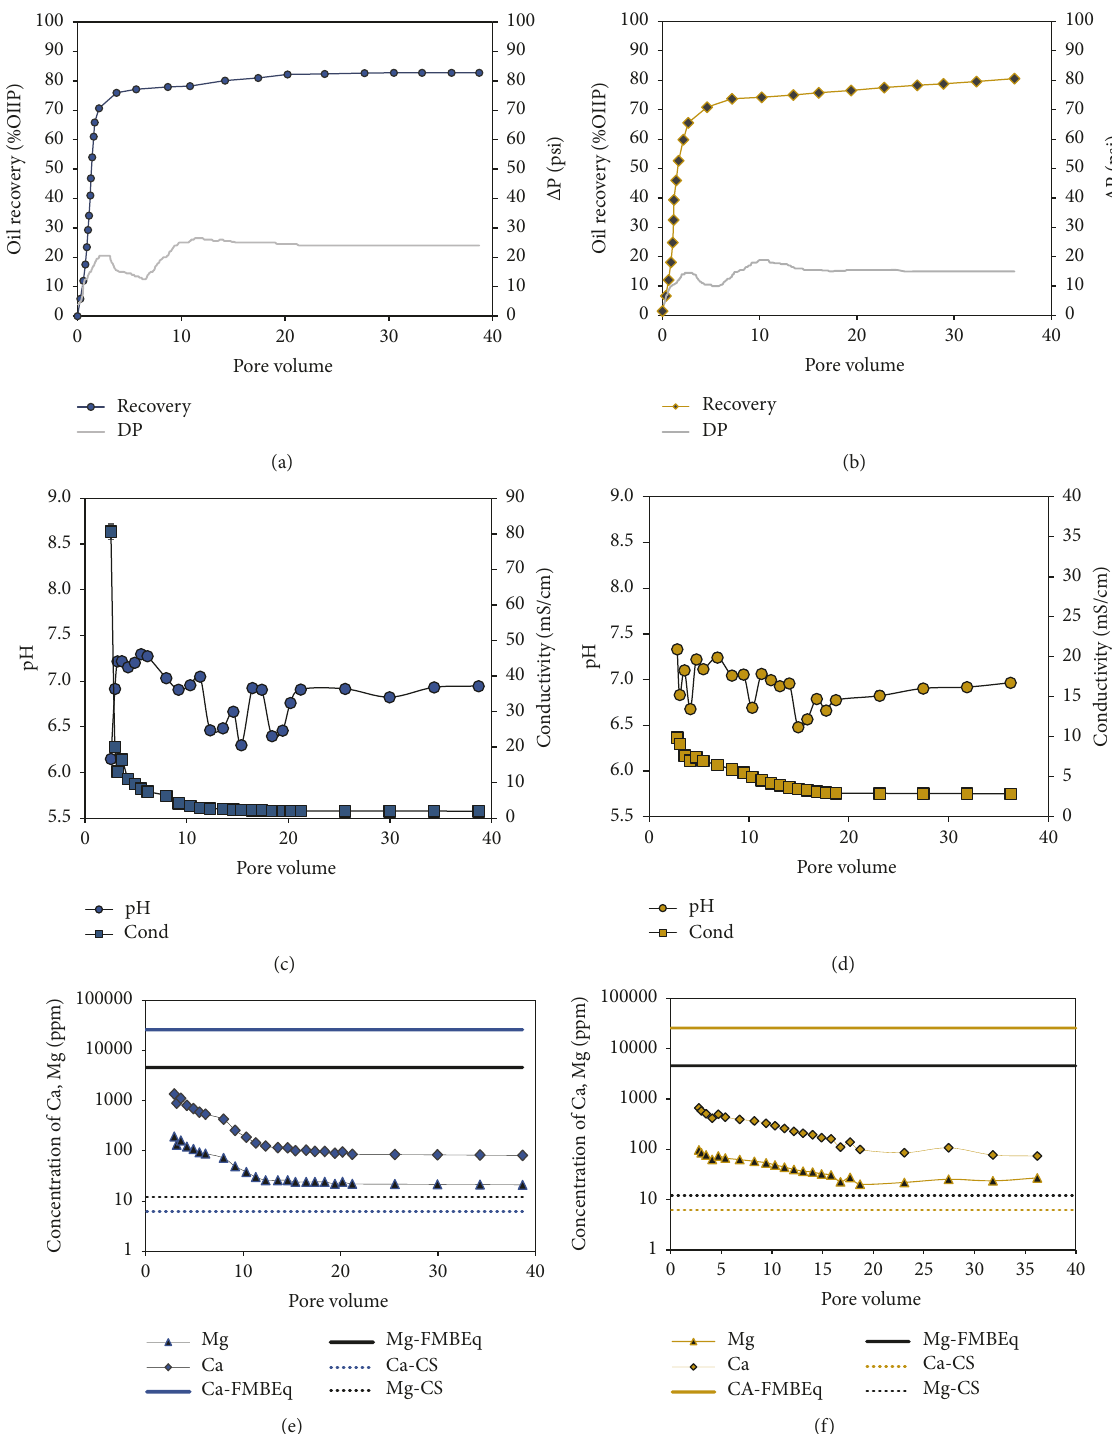
Figure 8: Secondary CSBSB flooding application greenzyme (a, c, e) and rhamnolipids (b, d, f): (a-b) cumulative oil recovery and differential pressure; (c-d) pH and conductivity of the effluent; (e-f) Ca 2+ and Mg 2+ analyses of the effluent. The straight lines indicate concentration of Ca 2+ (coloured) and Mg 2+ (black) in connate water saturation (—) and CSB injected